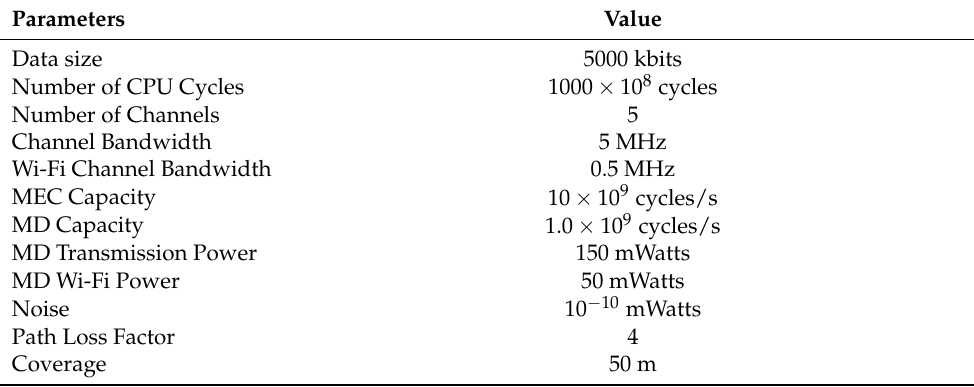
Table 2. Simulation